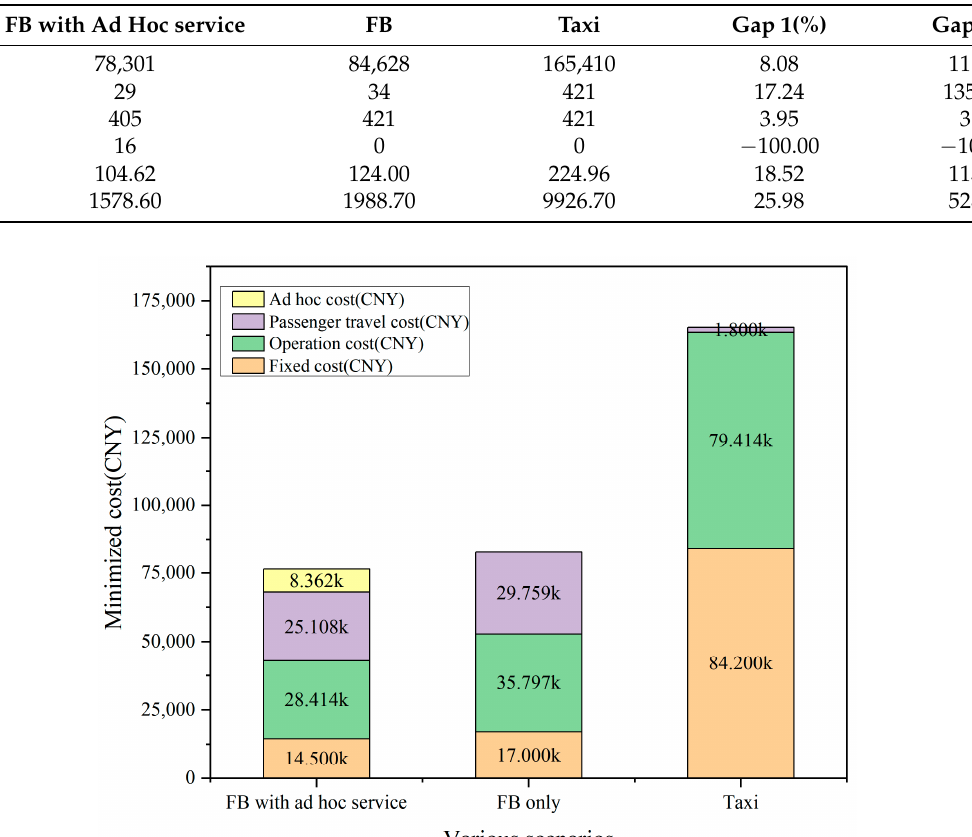
Table 8. Optimized results for various scenarios in Shenzhen airport.